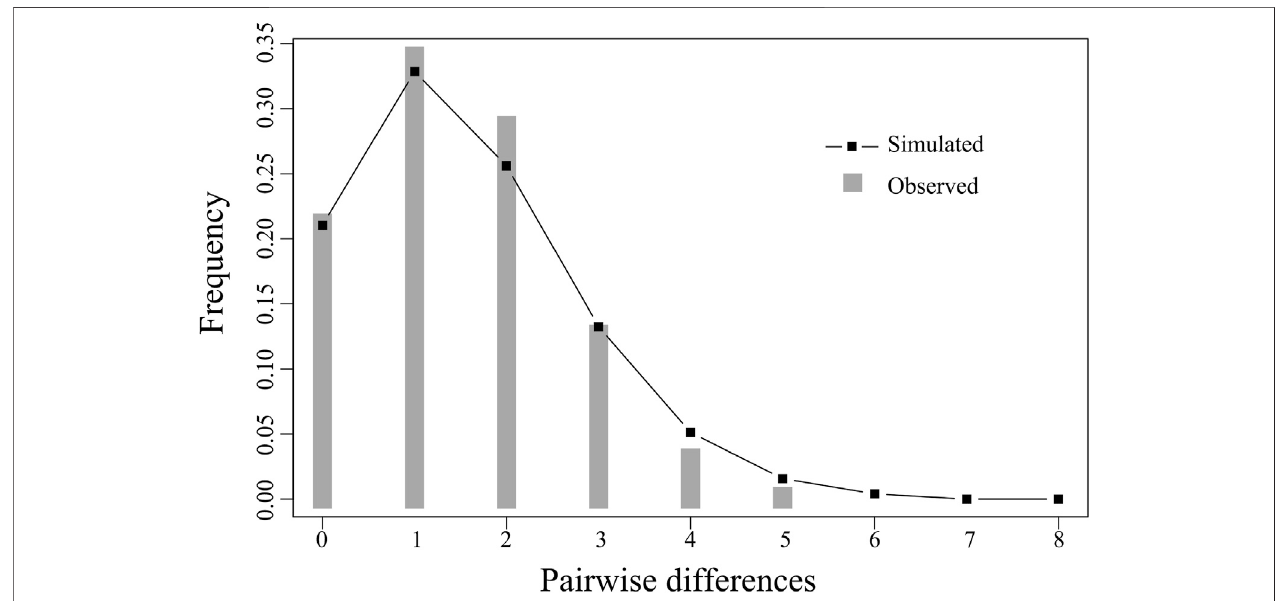
FIGURE 4 | Observed mismatch distributions (bars) and expected mismatch distributions under sudden expansion model (line) of COI for Evynnis cardinalis from Beibu Gulf.